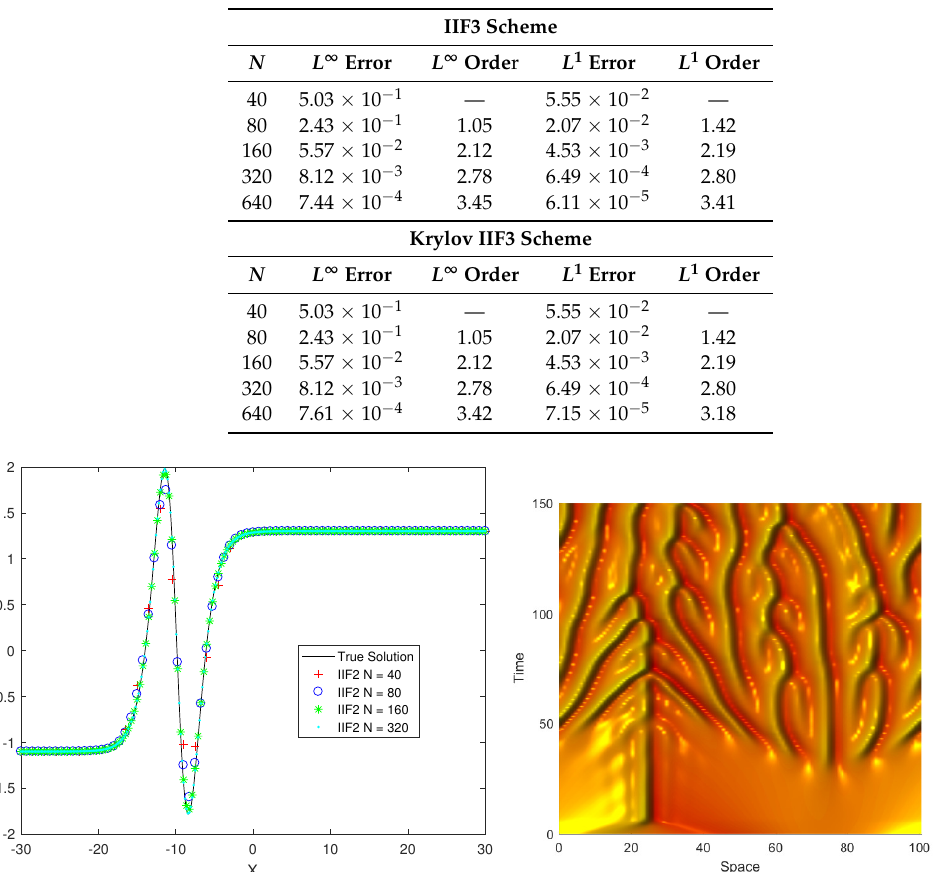
Table 2. Example 2. Kuramoto–Sivashinsky (KS) Equation (29). Numerical errors and orders of accuracy of the IIF3 and Krylov IIF3 schemes. The third-order weighted essentially non-oscillatory (WENO) scheme was used for discretizing the nonlinear hyperbolic term; ∆ t n = 0.1 ∆ x / max i | u n final time: T = 1.0.